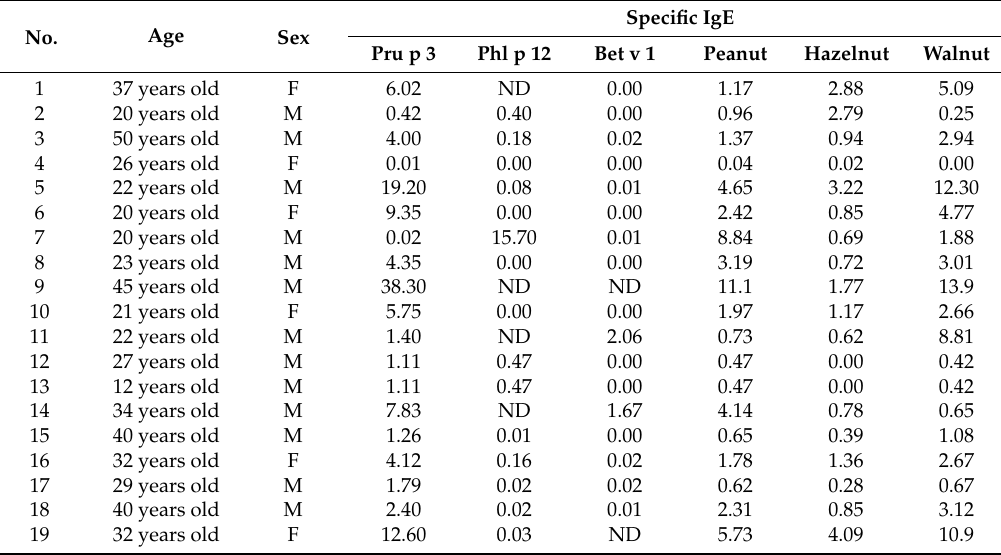
Table 1. Nut allergic patients from